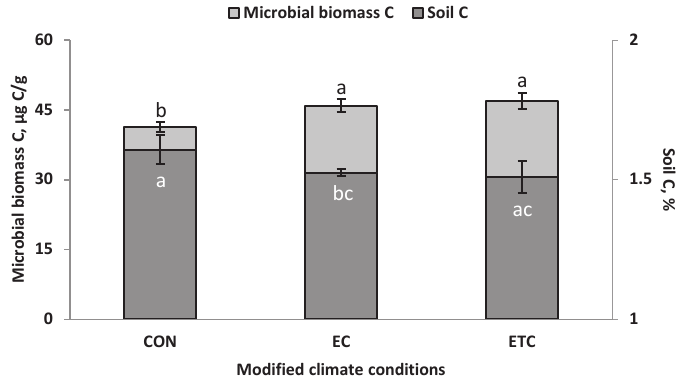
Fig. 3. Microbial biomass carbon and soil carbon under modified climate conditions (mean ± SE). Different letters indicate significant differences among treatments ( p < 0.05) based on U-test. Treatments: CON = ambient temperature and CO elevated temperature and